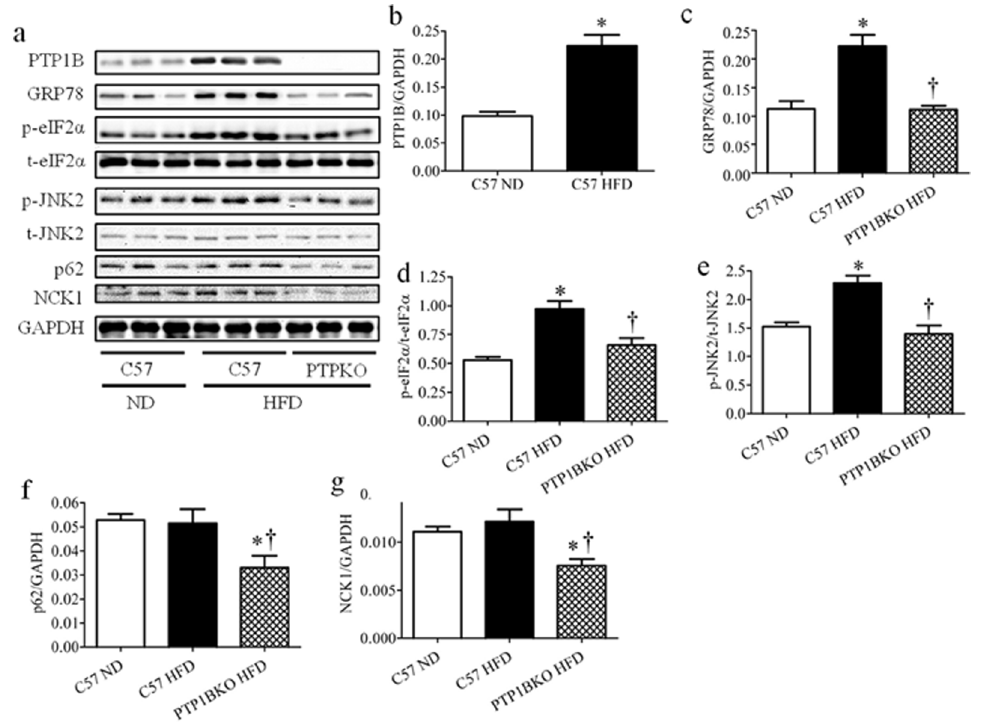
Figure 5. The effect of PTP1B deletion on short term high-fat diet-induced ER stress in skeletal muscle. Representative Western blots (a) and densitometric analysis (n=6) of PTP1B (b), GRP78 (c), phospho- and total-eIF2 a (p-eIF2 a and t-eIF2 a , respectively) (d), and phospho- and total- JNK2 (p-JNK and t-JNK, respectively) (e), p62 (f), and NCK1 (g) protein levels in gastrocnemius muscles of the C57 or PTP1BKO mice received normal (ND) or high-fat content (HFD) diets for 3 weeks. * p , 0.05 compared with C57 ND mice, { p , 0.05 compared with C57 HFD